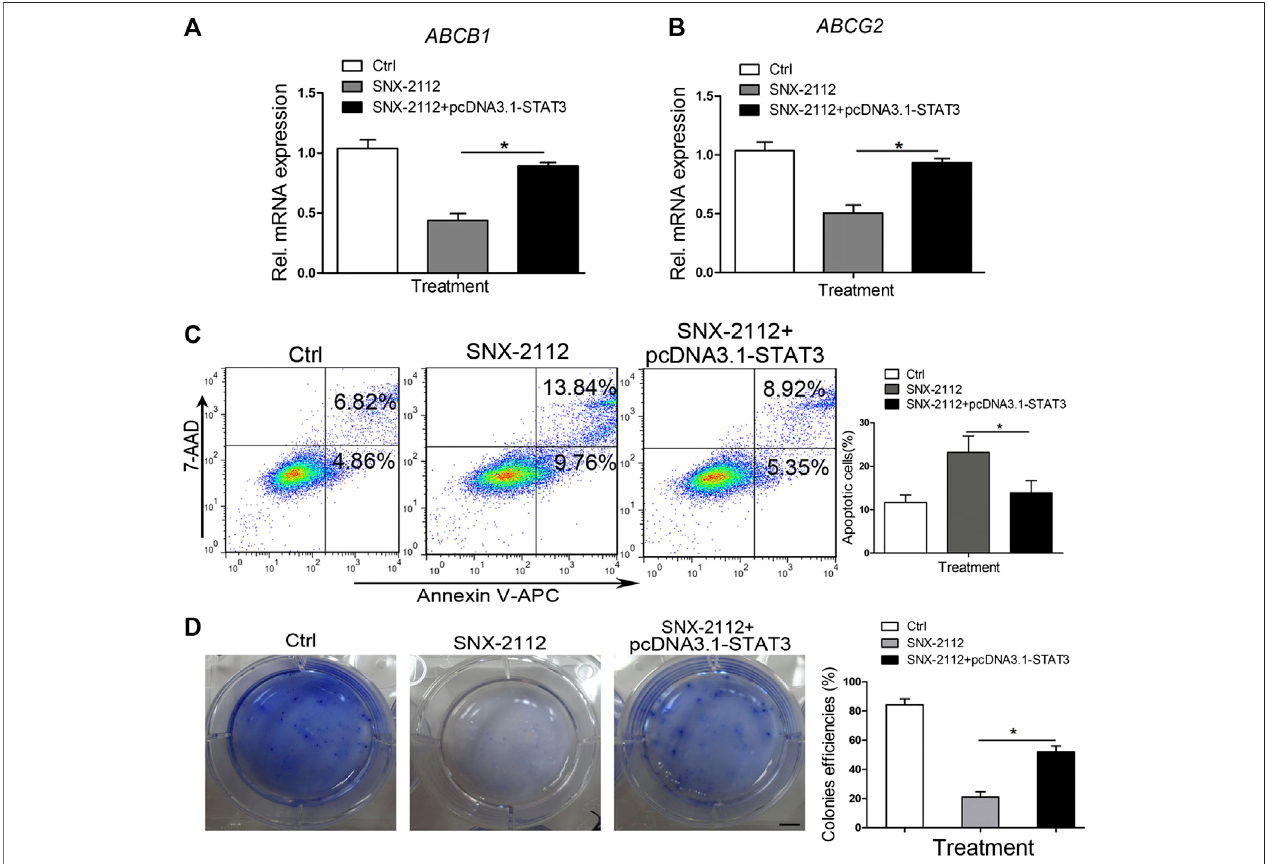
FIGURE 7 | STAT3 overexpression-reversing SNX-2112-induced ECSLCs apoptosis (A,B) qPCR analysis of ABCB1 and ABCG2 expression level in ECSLCs. ECSLCs were transfected with pcDNA3.1-STAT3 vectors and after 72 h the ECSLCs were treated with 0.2 μ M SNX-2112 for 24 h. (C) Flow cytometry analysis of ECSLCs. ECSLCs were treated with pcDNA3.1-STAT3 vectors for 72 h and 0.2 μ M SNX-2112 for 24 h. (D) The colony formation ef fi ciency analysis of ECSLCs treated with pcDNA3.1-STAT3 vectors and SNX-2112. Approximately 1 × 103 ECSLCs were treated with pcDNA3.1-STAT3 vectors for 72 h and then 0.2 μ M SNX-2112 for 24 h. These cells were then cultured on soft agar plates for 14 days, followed by staining with 0.5% crystal violet. Scale bar, 10 mm.